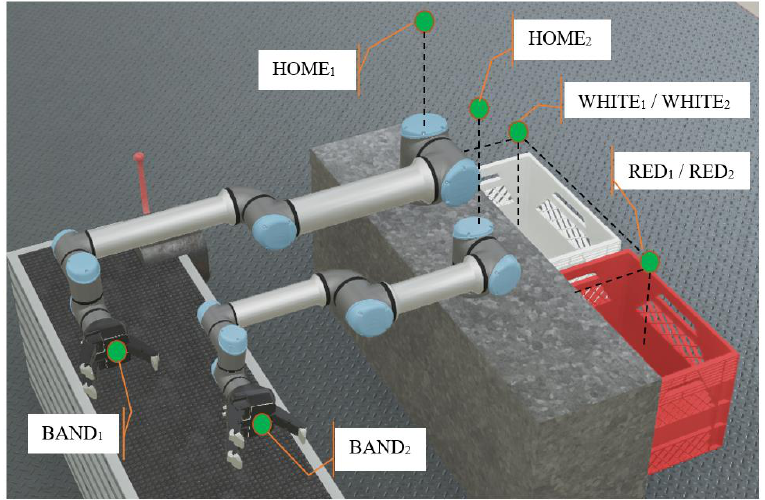
Figure 4. The target and waypoints of robots.